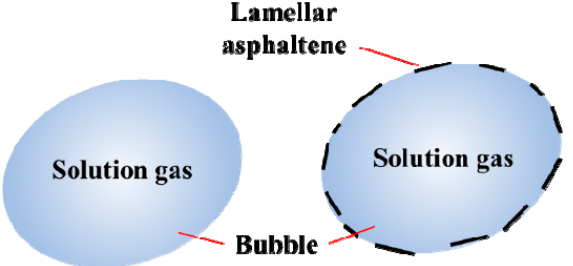
Figure 15. Schematic showing how asphaltene plays a protective role akin to armor on the bubble film.